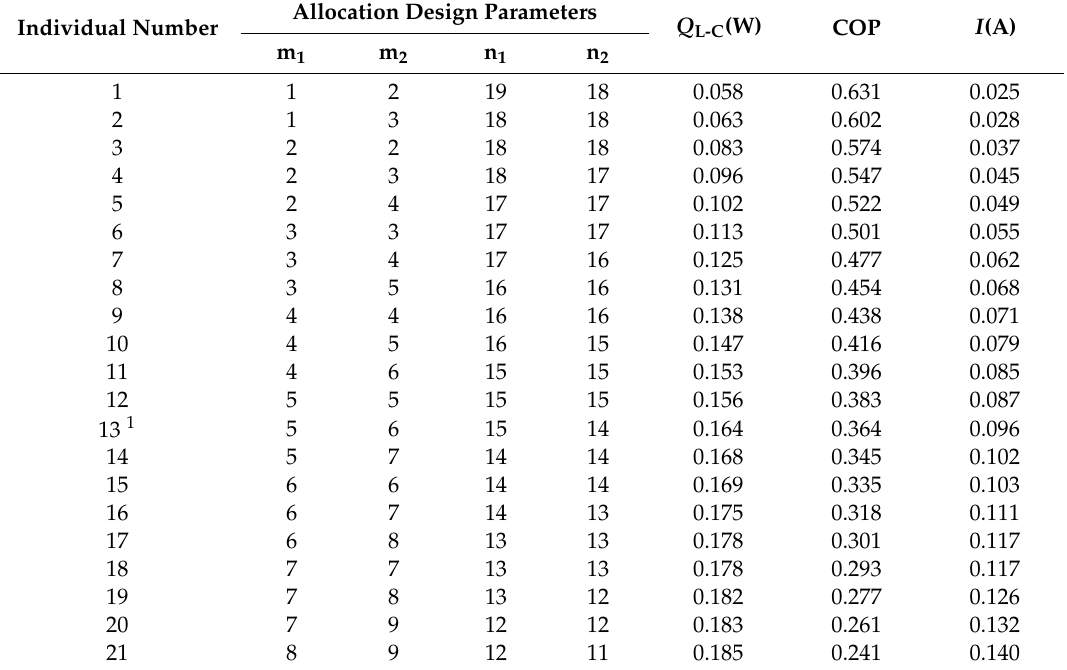
Table A4. The value of search variables and performance metrics for the improved CTE system. Individual